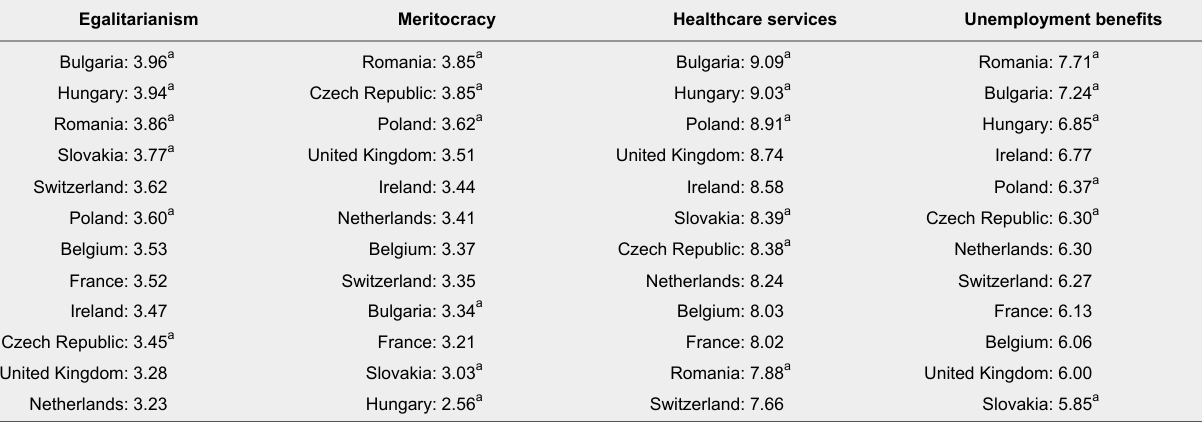
National Mean Scores of Support for Welfare Services and Distributional Justice Principles